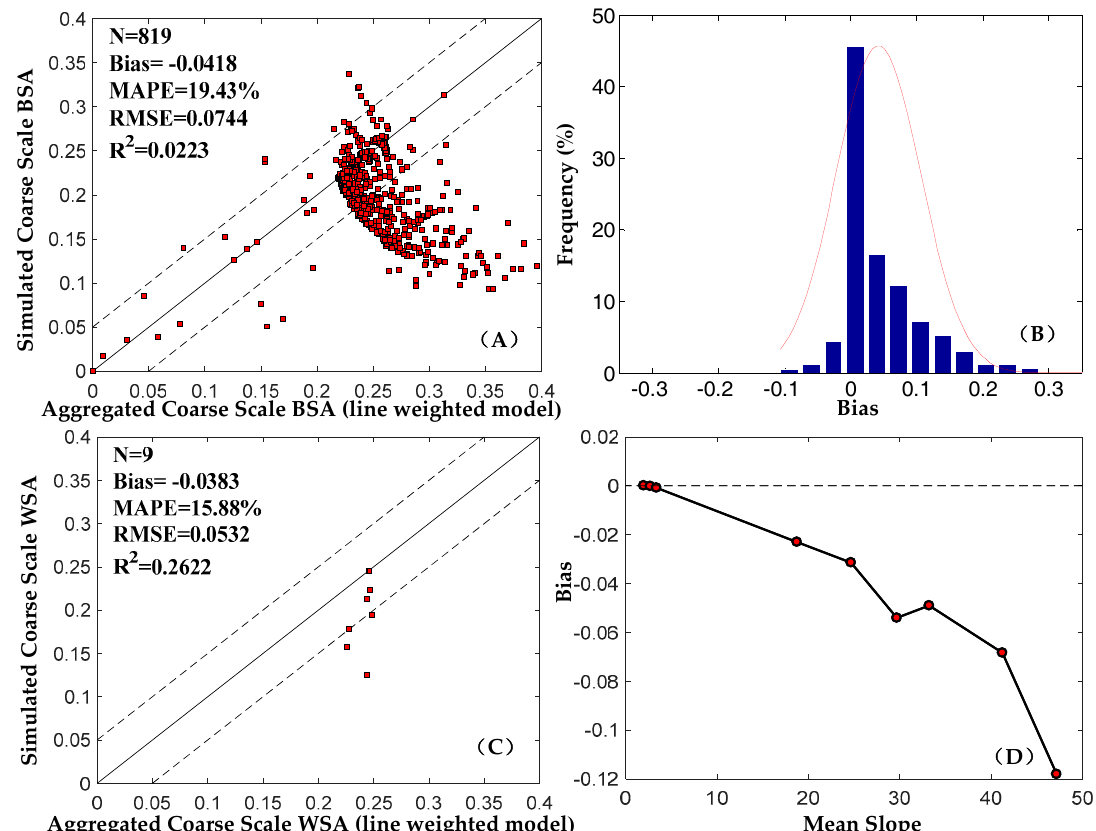
Figure 8. Scatter plots and the histogram evaluate the fine scale albedo against simulated coarse scale albedo for: ( A ) the aggregated fine scale BSA vs. the simulated coarse scale BSA; ( B ) the histogram of the aggregated fine scale BSA minus the coarse scale BSA; ( C ) the aggregated fine scale WSA vs. the simulated coarse scale WSA; and ( D ) the bias distribution of the aggregated fine scale WSA and the coarse scale WSA following the increase of the mean slopes. Table 4. Statistical metrics from the validation between coarse scale BSA and aggregated fine scale BSA aggregated by different upscaling methods ( α * means the slope of the DEM). Aggregated Fine Scale BSA (MRT-Based Aggregated Fine Scale BSA (Linear Weighted Average Upscaling Model) vs. Upscaling Model) vs. Simulated Coarse Scale Parameters Simulated Coarse Scale Albedo BSA BSA